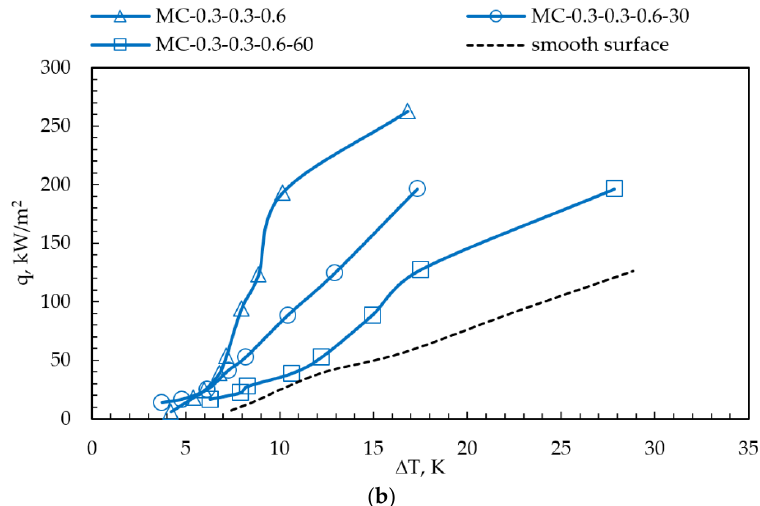
Figure 6. Pool boiling curves for NOVEC-649, width of microchannel 0.3 mm. ( a ) Pool boiling heat transfer; ( b ) boiling curves.